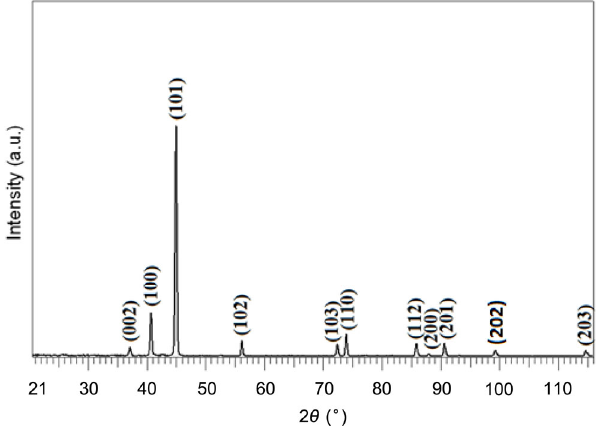
Fig. 2 XRD phase characterization of LHE Cd coating.